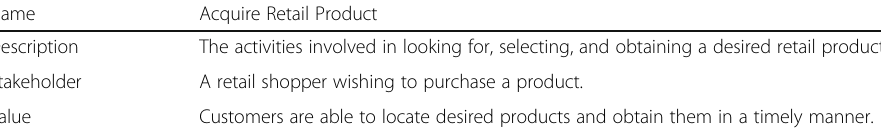
Table 11 An Example of Value Strem of Acquiring Retail Product in TOGAf (The Open